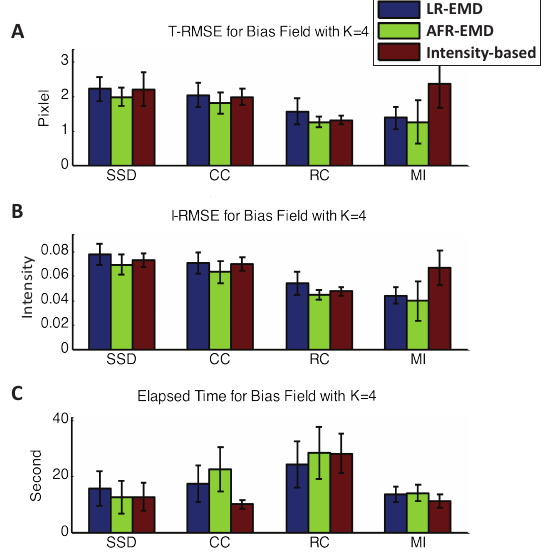
Figure A2. Registration performance in the presence of four Gaussian kernels. Mean and variance of T-RMSE and I-RMSE for images in BrainWeb dataset are shown in ( A , B ) panels. ( C ) panel compares the running time for all